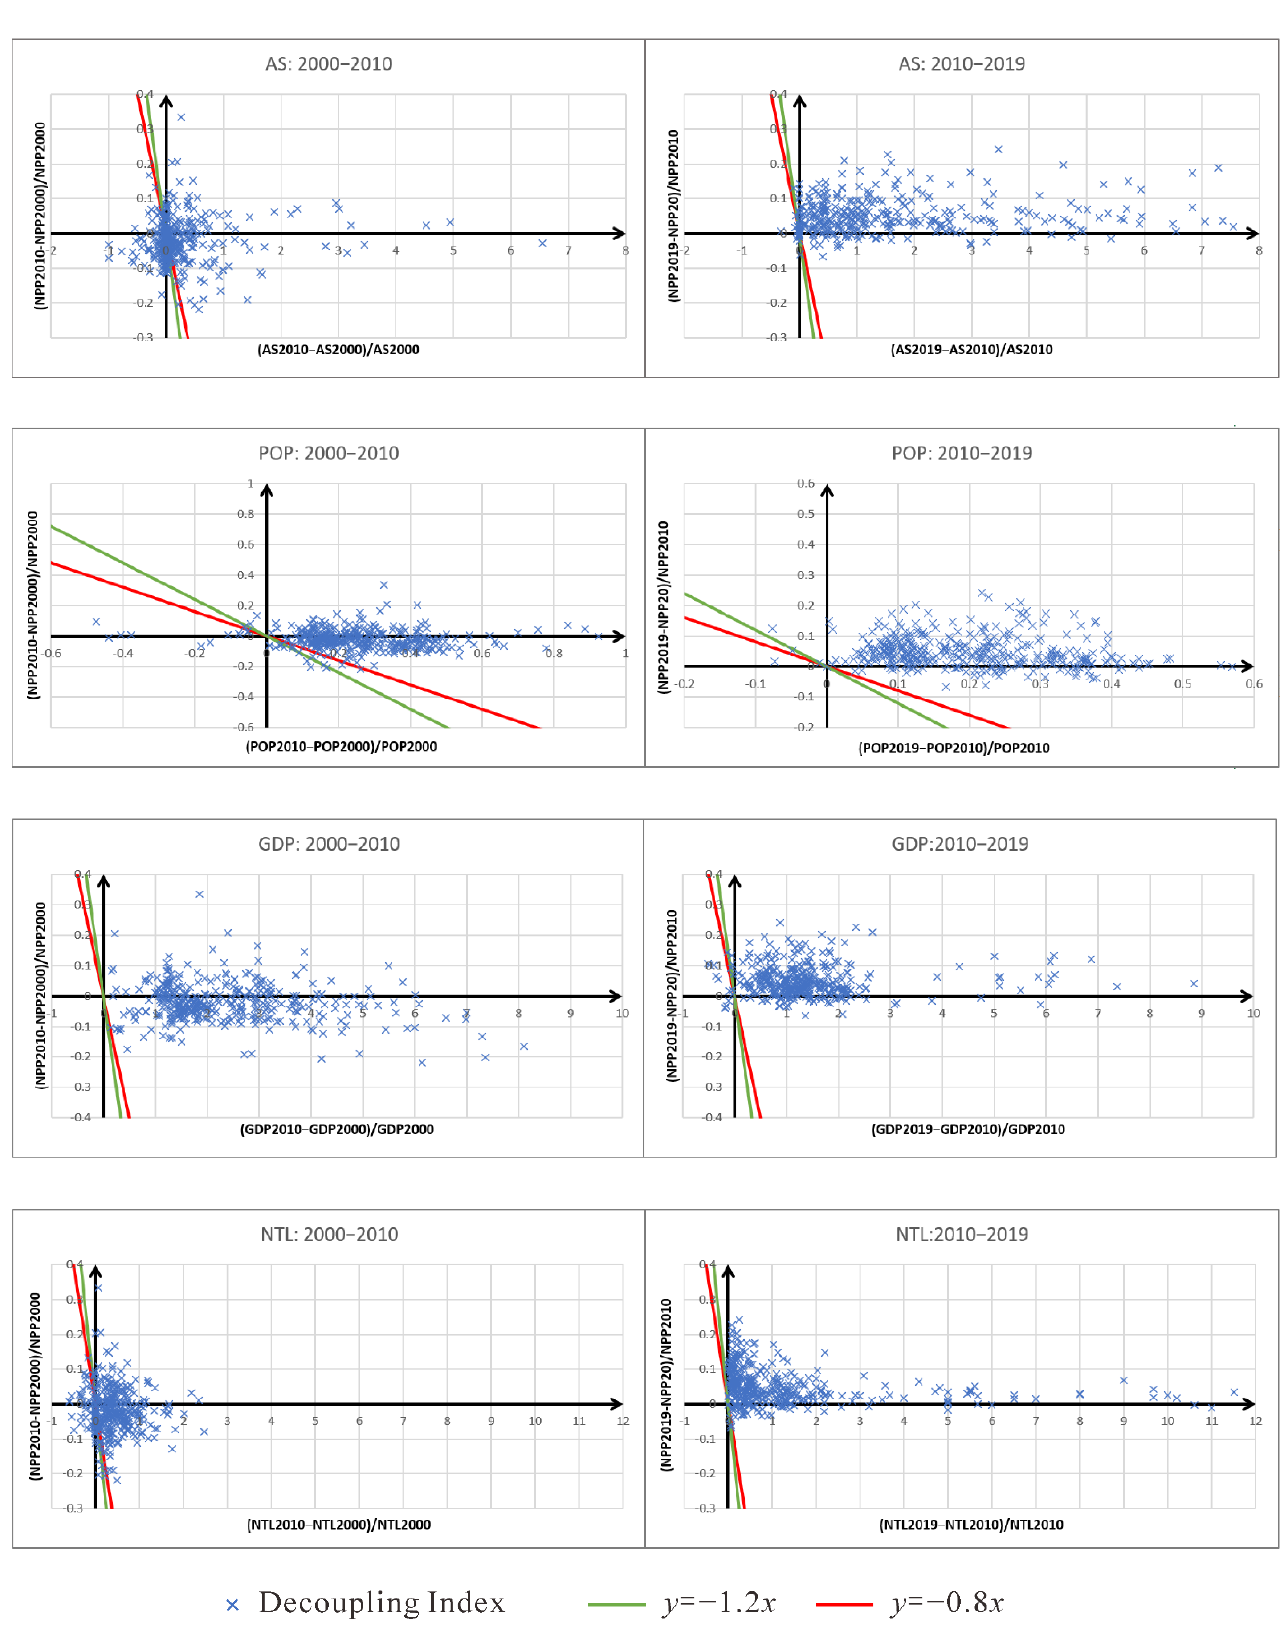
Figure 11. Changes in the decoupling level between socioeconomic factors and net primary produc- tivity (NPP) at the watershed scale.